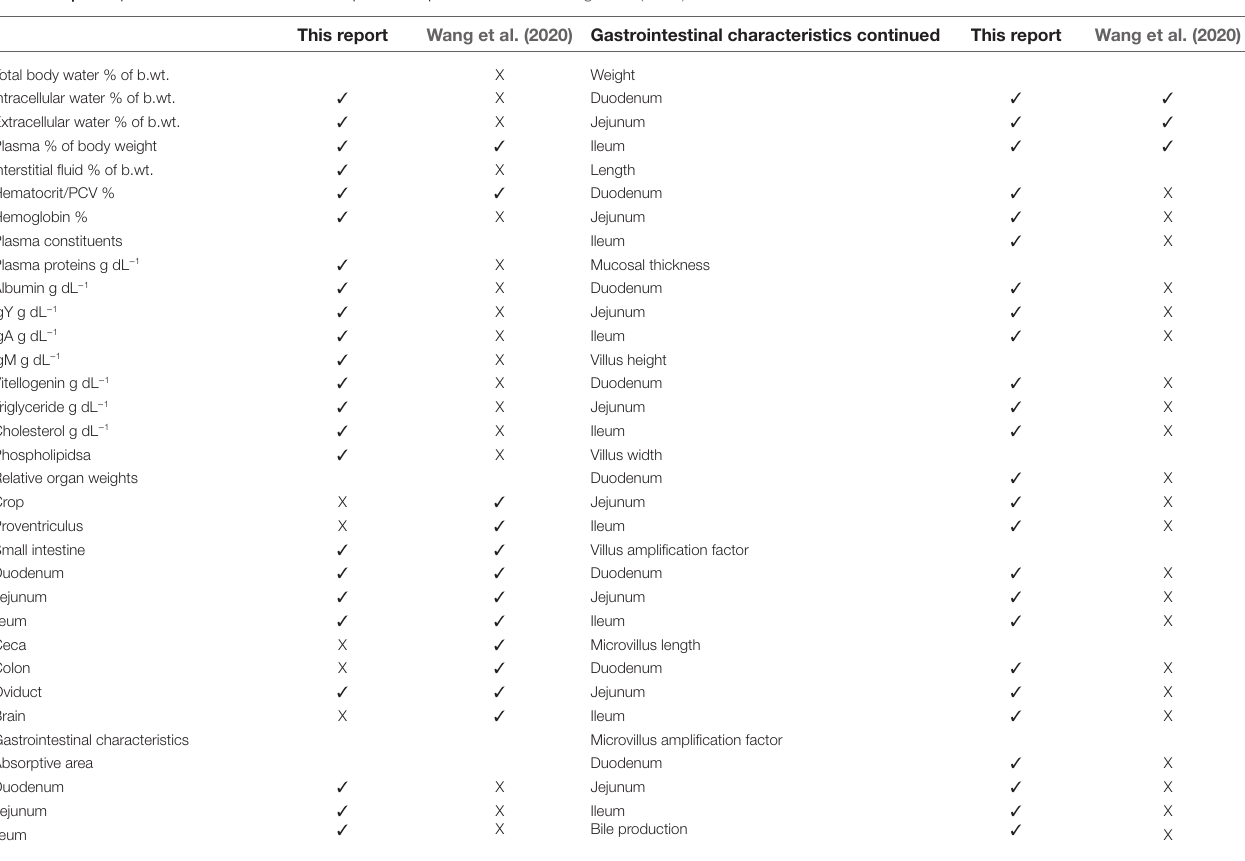
TABLE 9 | Comparison of data included in the present report and that of Wang et al. (2020). This report Total body water % of